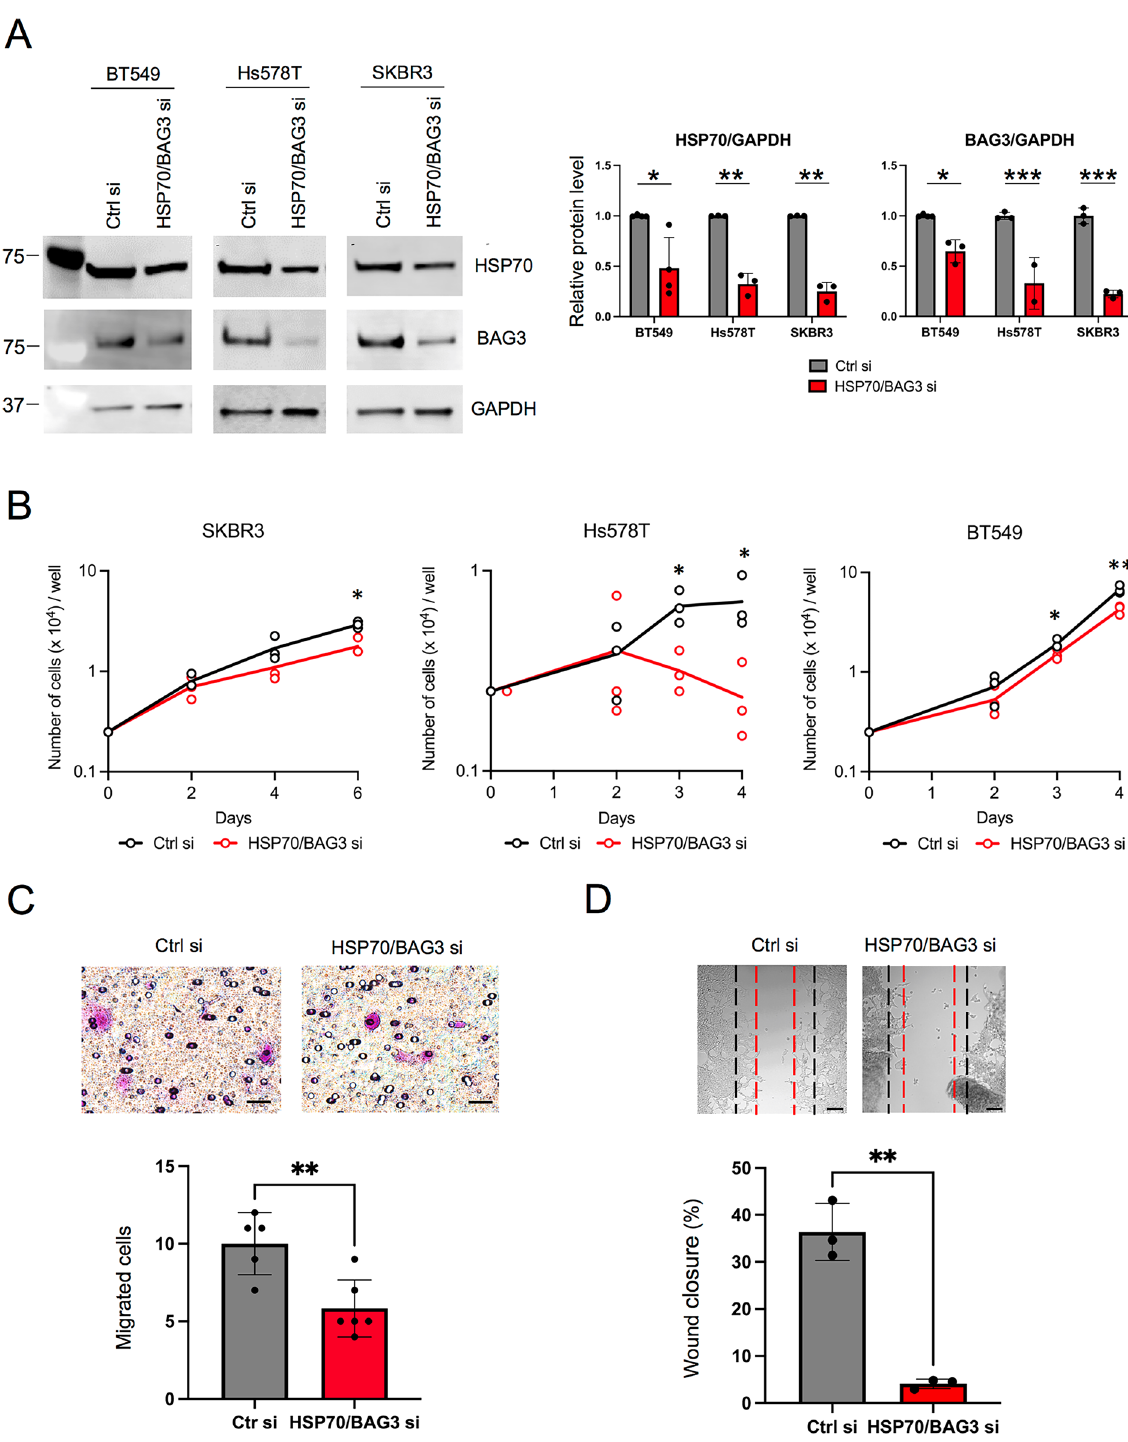
Figure 8. Direct HSP70/BAG3 siRNA knockdown impact tumor growth and migration. ( A ) Western blot analysis of HSP70, BAG3 and GAPDH protein expression in breast cancer cell line 72 h after transfection with 20 nM of HSP70/BAG3 siRNA or non-targeting siRNA. Quantitative analyses of western blot for HSP70 and BAG3 of three individual experiments and the individual data points were indicated in a circle. (n = 3; *p < 0.05, **p < 0.01, ***p < 0.001, Student’s t-test, error bars = SD). GAPDH was used as an internal control. Molecular weight markers are indicated in kilodalton. Original blots are presented in Supplementary Fig. S10. ( B ) Growth curves of control siRNA or HSP70/BAG3 siRNA transfected SKBR3, Hs578T and BT549 cells. Representative image of three individual experiments with three replicates (n = 3; *p < 0.05, **p < 0.01, Student’s t-test, error bars = SD). ( C ) Upper: representative images of migrated cells that have migrated through filters and migration activities of SKBR3 cells treated with control non-targeting siRNA or HSP70/BAG3 siRNA. Scale bars, 20 μm. Lower image shows quantitation of numbers of cells migrating through the filter (means ± SD). Representative image of three individual experiments with three replicates (n = 3; **p < 0.01, Student’s t-test, error bars = SD). ( D ) Upper: representative cell culture images at 24 h after the wounding. Dashed black line: initial wounds. Dashed red line: closed wounds at 24 h. Scale bars, 100 μm. Lower images show the relative rates of the wound closure. Representative image of three individual experiments with three replicates (n = 3; **p < 0.01, Student’s t-test, error bars =